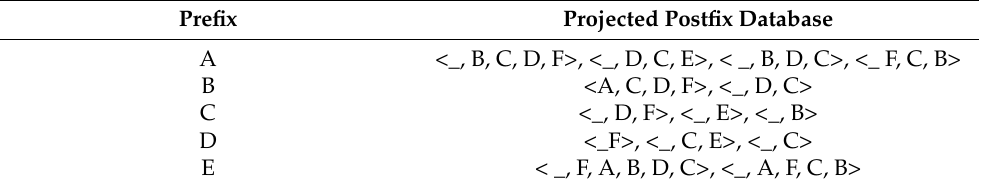
Table 6. Projected database.